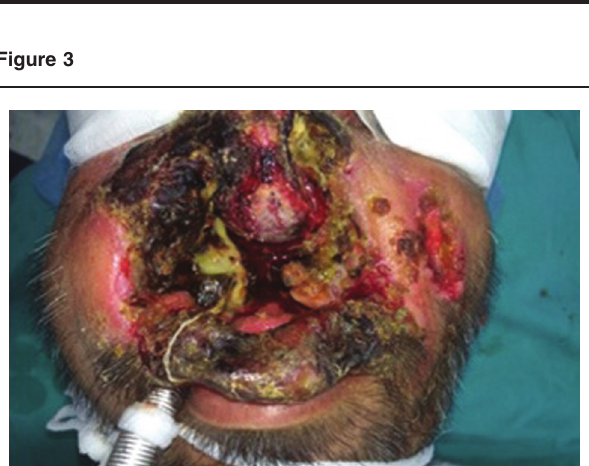
Coronal and axial CT images showing defects. CT, computed tomog- raphy.